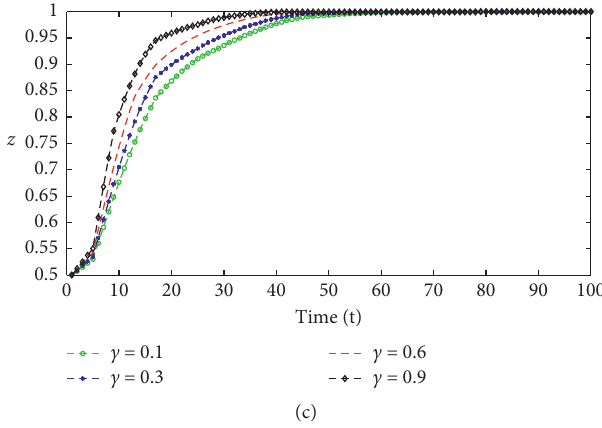
Figure 4: The effect of adoption subsidies on the evolutionary